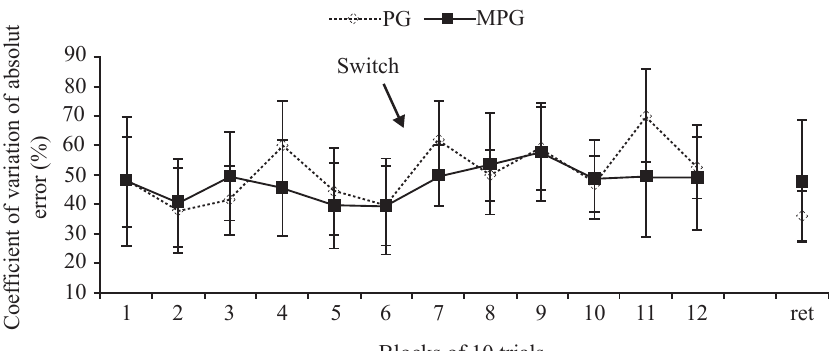
Figure 4. Coefficient of variation of the absolute error in the acquisition phase and in the retention test. The vertical bars denote the confidence interval in